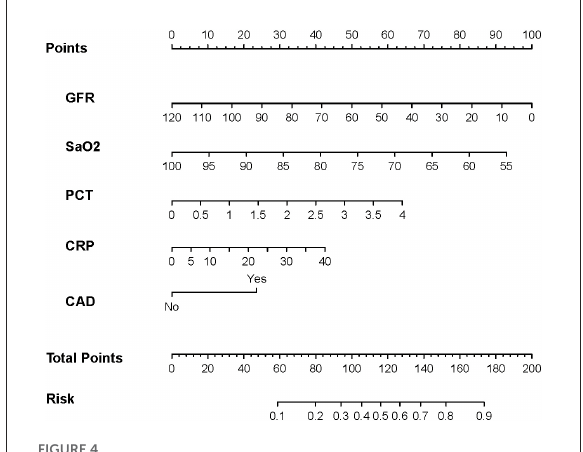
FIGURE4 The nomogram was developed in the training set. It included five factors: glomerular filtration rate (GFR), artery oxygen saturation (SaO2), procalcitonin (PCT), C-reactive protein (CRP), and history of coronary artery disease (CAD). The nomogram plot provides a visual way to predict the risk of AKI for COVID-19